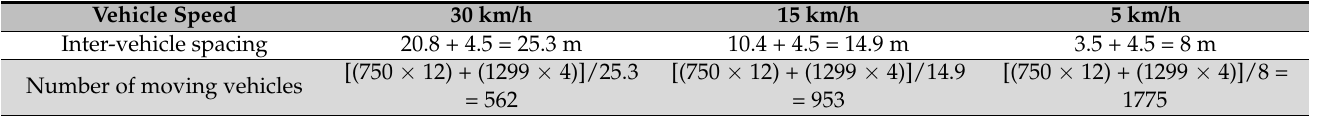
Table 12. Number of moving vehicles in the urban grid road environment for multiple speeds. Vehicle